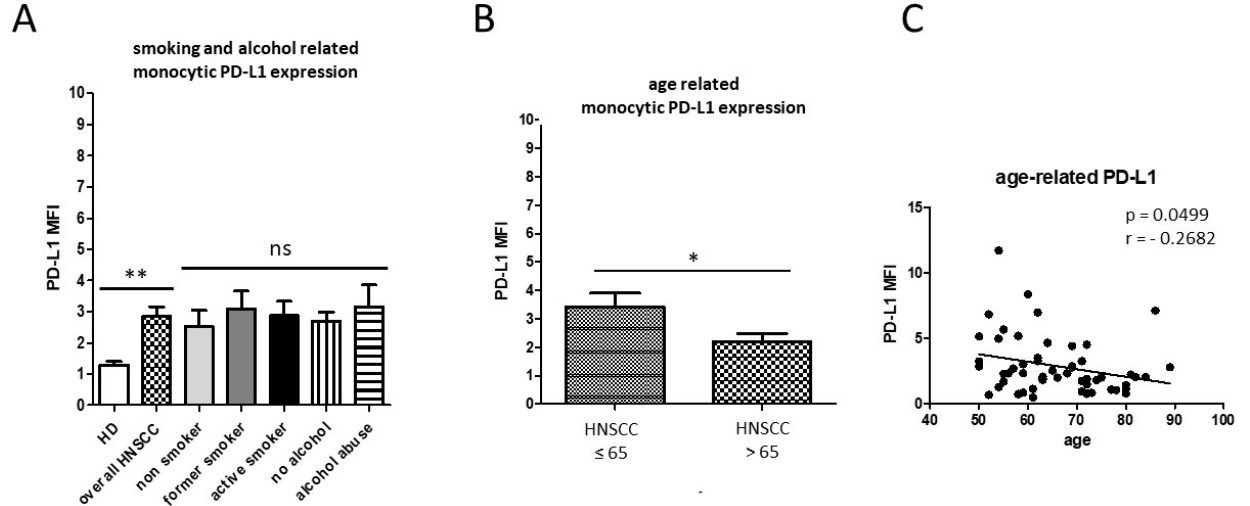
Figure 2. Flow cytometric analysis of PD-L1 expression. ( A ) HNSCC patients ( n = 64) revealed significantly increased expression levels of monocytic PD-L1 compared to healthy donors, but no significant differences between the smoking- and alcohol-related subgroups (** p < 0.01; ns = not significant). ( B ) HNSCC patients > 65 revealed significantly decreased expression levels of monocytic PD-L1 compared to HNSCC patients ≤ 65 (* p < 0.05). ( C ) Correlation analysis between monocytic PD-L1 expression and age of HNSCC patients revealed a significant negative correlation. The Pearson correlation coefficient (r) and p values are given. p < 0.05 was considered as significant.